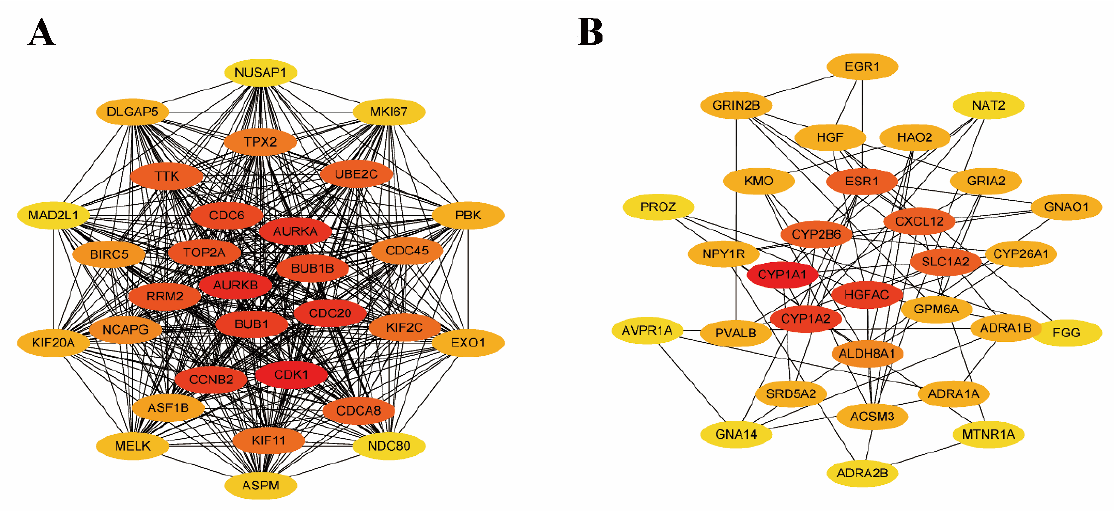
Figure 4. The top 30 hub genes were identified from DE mRNAs. The redder the color, the higher the ranking. ( A ) Visualization of the top 30 upregulated hub DE mRNA. ( B ) Visualization of the top 30 downregulated hub DE mRNA.